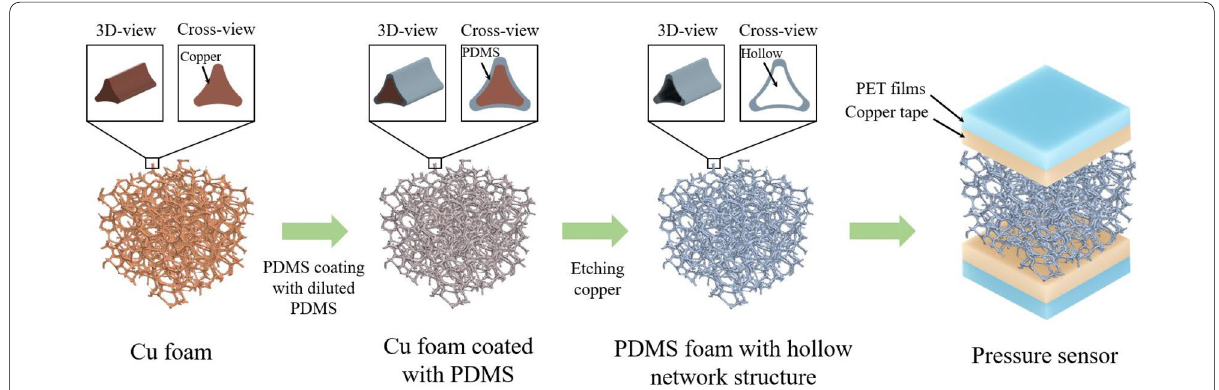
Fig. 1 Schematic illustration of the fabrication process of the porous structured capacitive pressure sensor using copper foam as a